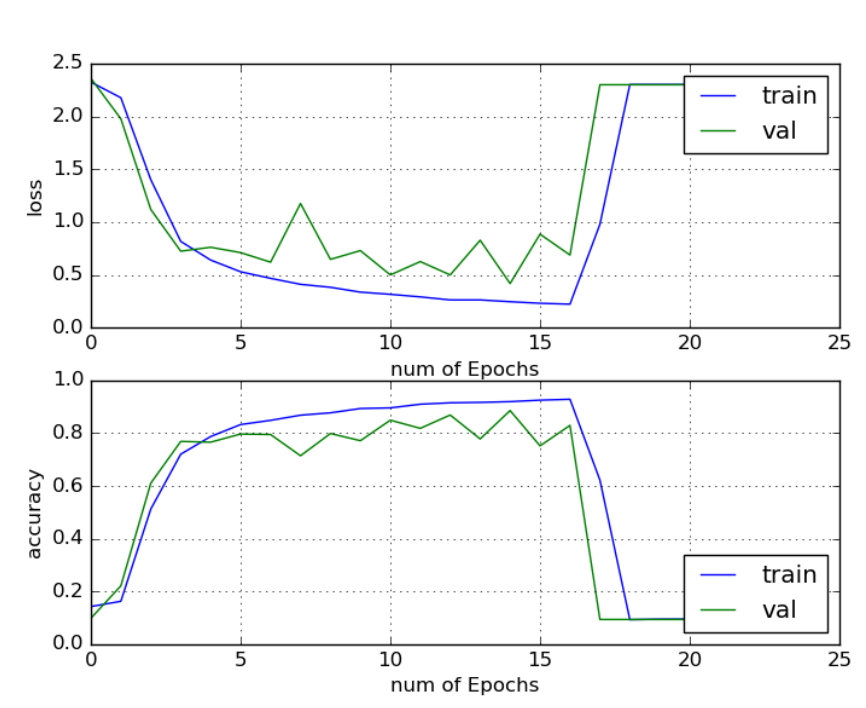
Figure 4. VGG-16 fine tune model on CVSI-15 using RMSprop optimizer.